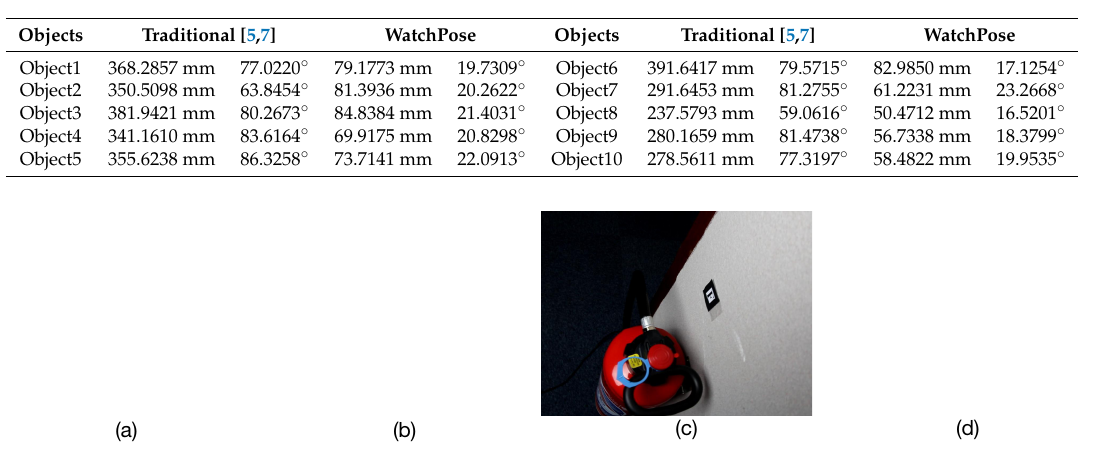
Table 2. Estimated camera location (mm) and orientation ( ◦ ) errors of objects using traditional and WatchPose data collection methods.